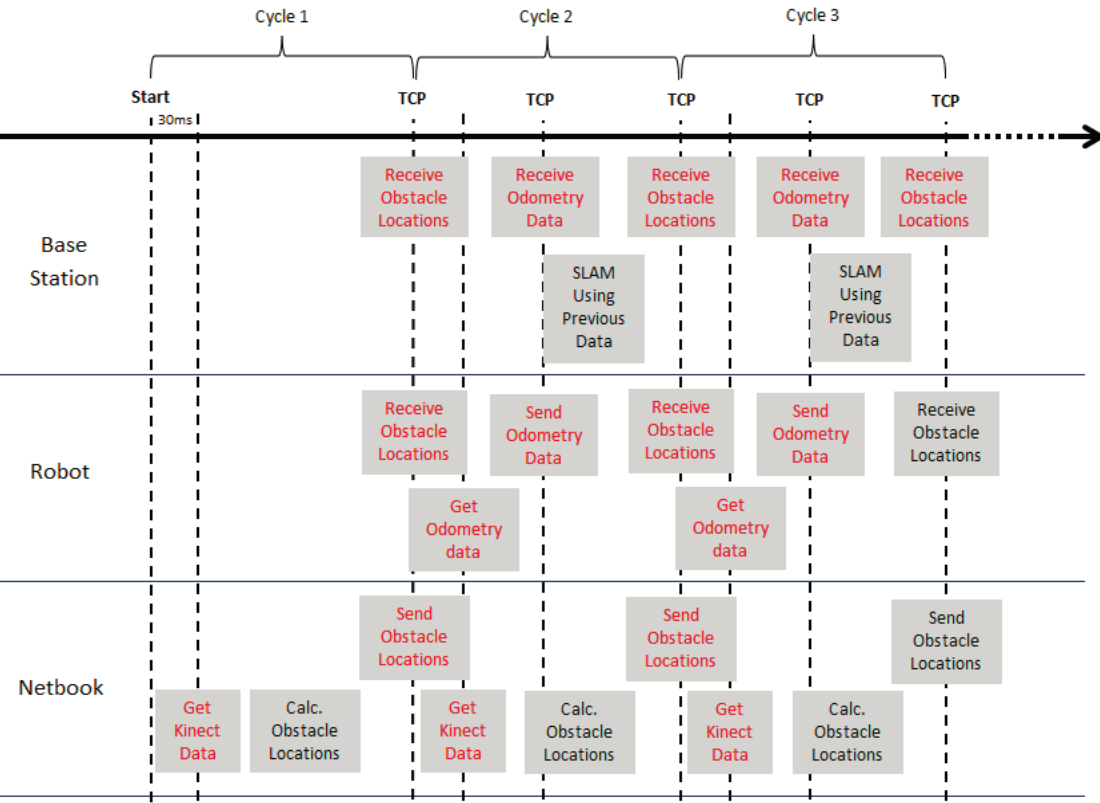
Figure 4. Timeline of synchronization between robot, netbook and base station. The red colored texts indicate the time-critical events which are synchronized between multiple